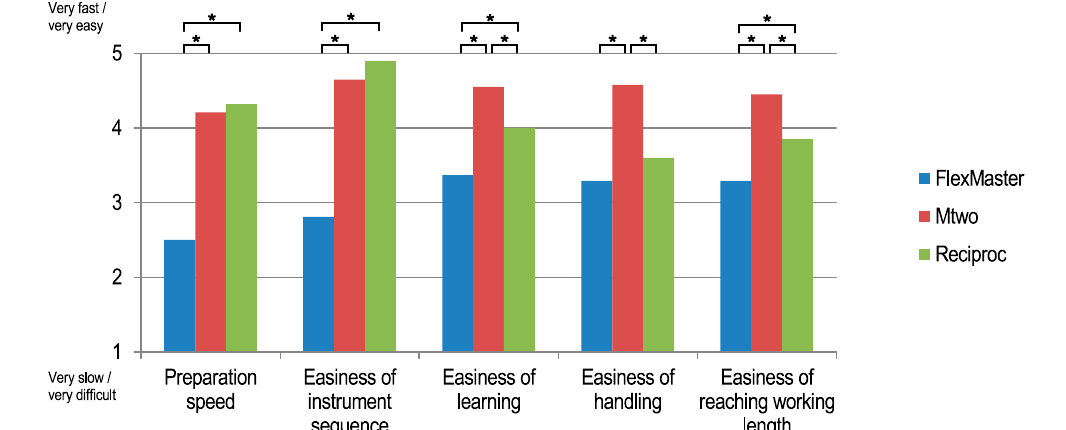
between groups at p < 0.05 (ANOVA with post hoc Tukey HSD).